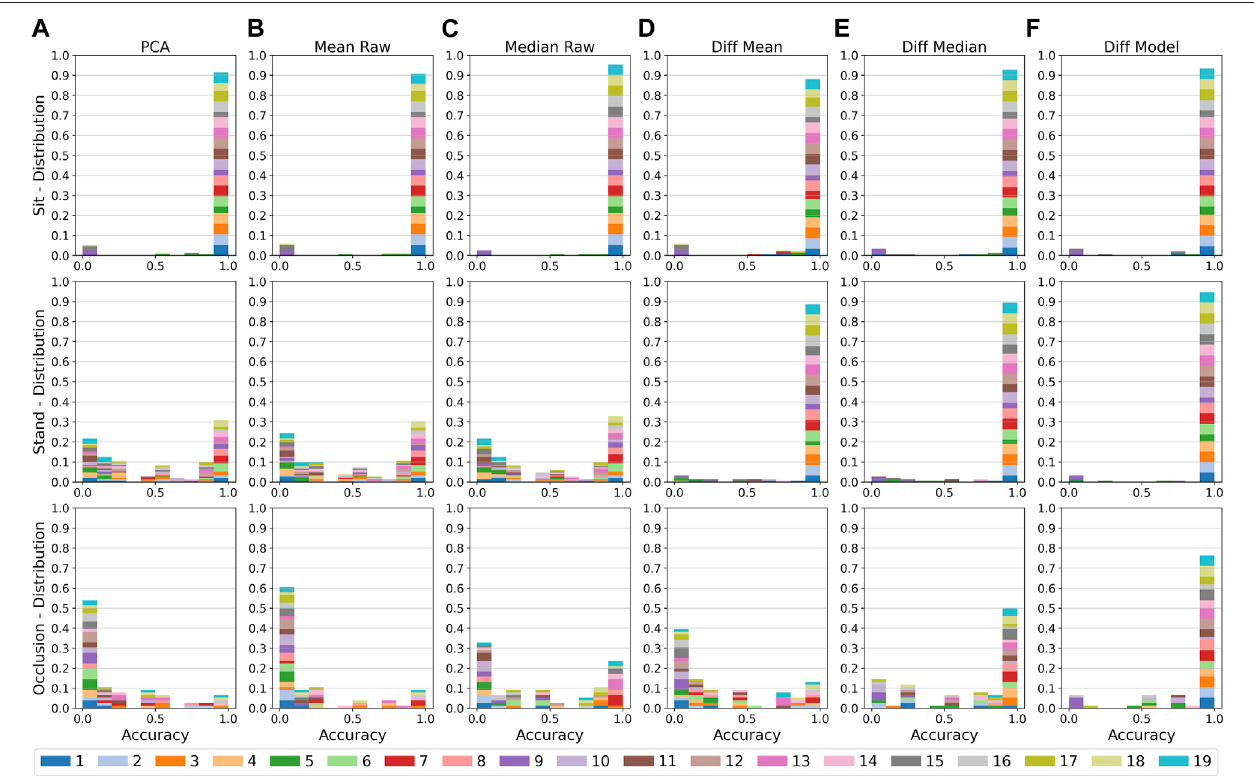
FIGURE12| Histogram oftheaccuracydistributionofthesingleparticipants,withthebreathing signalcaptured fromthechest andusingaFastFourierTransform windowwithalengthof48 s.Histogramsaredividedintothedifferentmethods (A – F) PCA,MeanRaw,MedianRaw,DiffMean,DiffMedian,andDiffModel,and intothe conditions (top to bottom) sitting, standing, and occlusion. The x -axis indicates the accuracy value divided into 10 bins and the y -axis indicates the percentage of recordings that achieve this accuracy. The contributions of the individual participants are color-coded and stacked on top of each other. Ideally, all individual accuracy contributions are located in the rightmost bin, indicating that the respiratory rate can correctly be estimated on all recordings. A high bar in the 90 – 100% accuracy bin can be achieved by all methods during the sitting condition and by the difference based methods during the standing condition. During the occlusion condition, the 0 – 10% accuracy bin is dominant for all methods, except for the Diff Median and the Diff Model, which have 50% or 76% of the recordings in the 90 – 100% bin.